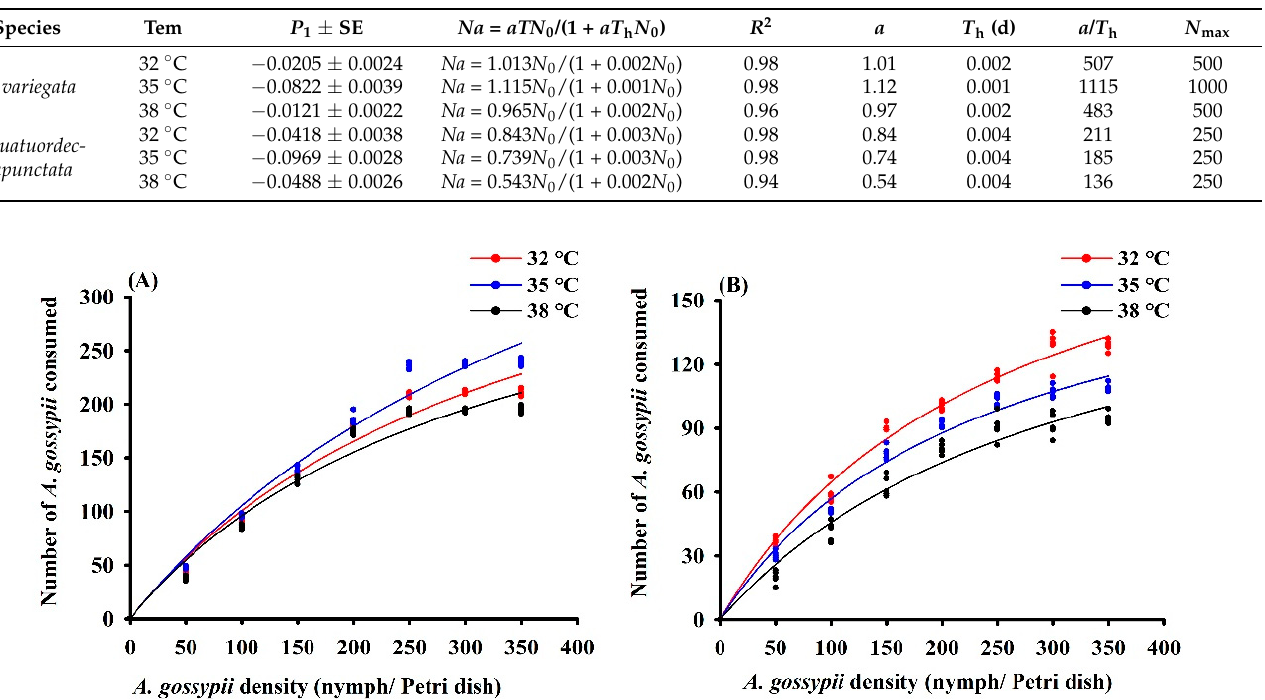
Figure 3. Functional response curves of adult female Hippodamia variegata ( A ) and Propylaea quatuordecimpunctata ( B ) to 4th instar Aphis gossypii at different temperatures.